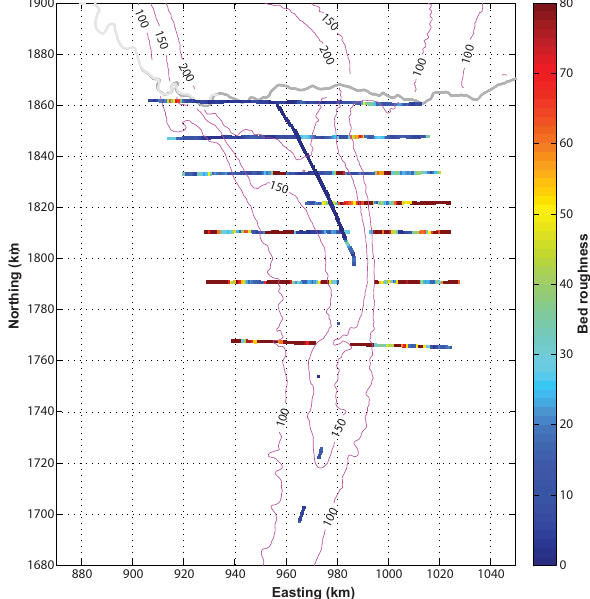
Fig. 3. Bed roughness analysis. Bed roughness index of the basal to- pography (colour) calculated for wavelengths ranging from 200 to 6400m. The grounding line is the same as in Fig. 1b. Short legs of absent bed echoes result in long gaps in the estimated bed roughness indices due the window-based calculation of the bed roughness in- dex. Larger RI corresponds to rougher bed. Contour lines represent surface speed (ma − 1